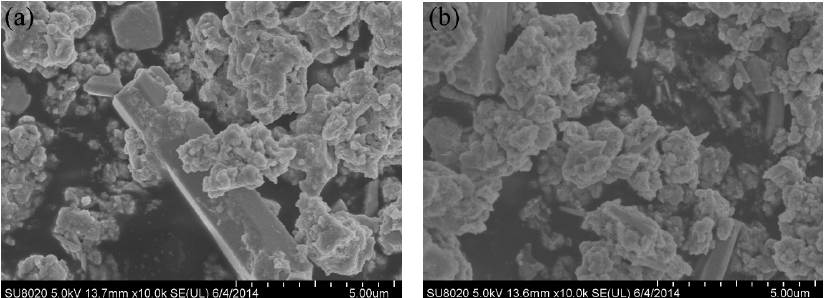
Figure 2. Scanning electron microscopy (SEM) micrographs of precursor powders before reduction in hydrogen. ( a ) W–1 wt % Nd 2 O 3 ; ( b ) W–1 wt % CeO 2 .